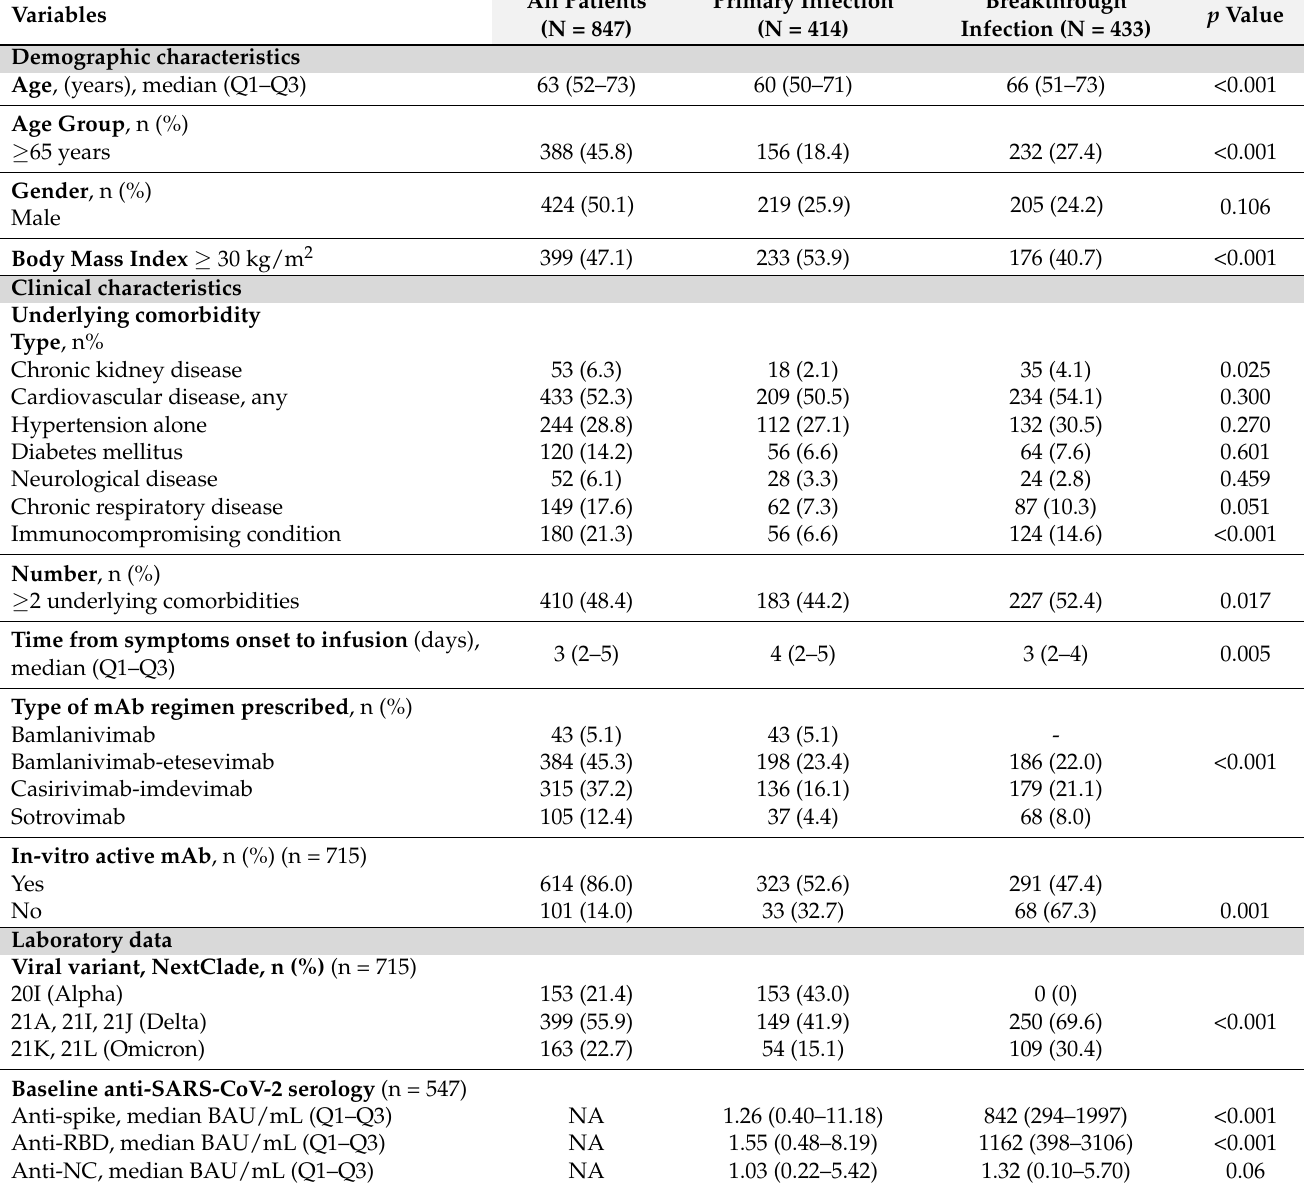
Table 1. Baseline demographic, clinical, and laboratory data of the study population, overall and stratified by type of infection: primary infection and breakthrough